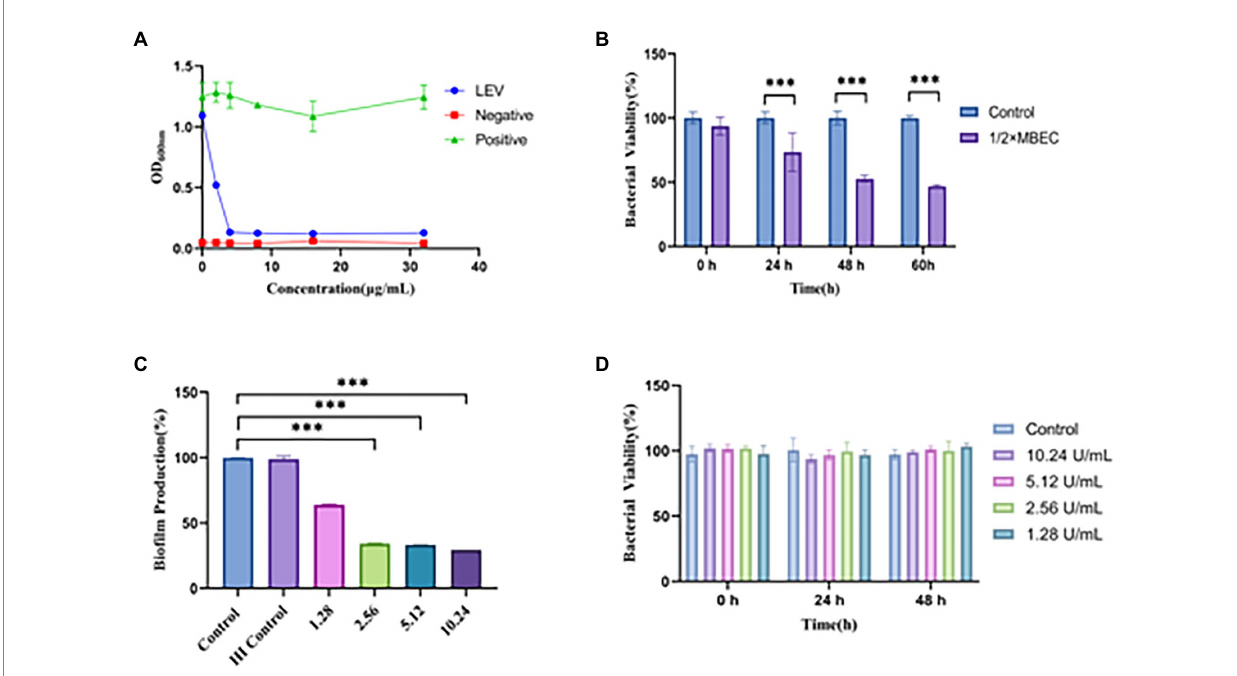
FIGURE 3 Antimicrobial susceptibility of LEV and CL to biofilm. (A) OD 600 values of BCG solutes after treatment with different concentrations of LEV, Negative (adding only blank broth without bacterial solution), Positive (adding bacterial solution without drug solution); (B) Effect of different times of LEV action of 1/2 × MBEC on the activity of BCG biofilm; (C) Inhibition effect of different concentrations of CL on BCG biofilm; (D) Effect of different concentrations of CL on planktonic BCG *** p < 0.001; HI: Heat-inactivated; Percentage of bacterial viability = ( A treatment − A blank )/( A control − A blank ) × 100% (where, A =